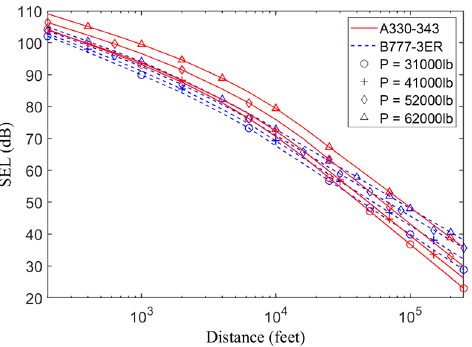
Figure 21. A330 and B777 aircraft noise impact (SEL) as recorded for various power settings (cor- rected thrust) and propagation distances. Excerpted from NPD database.